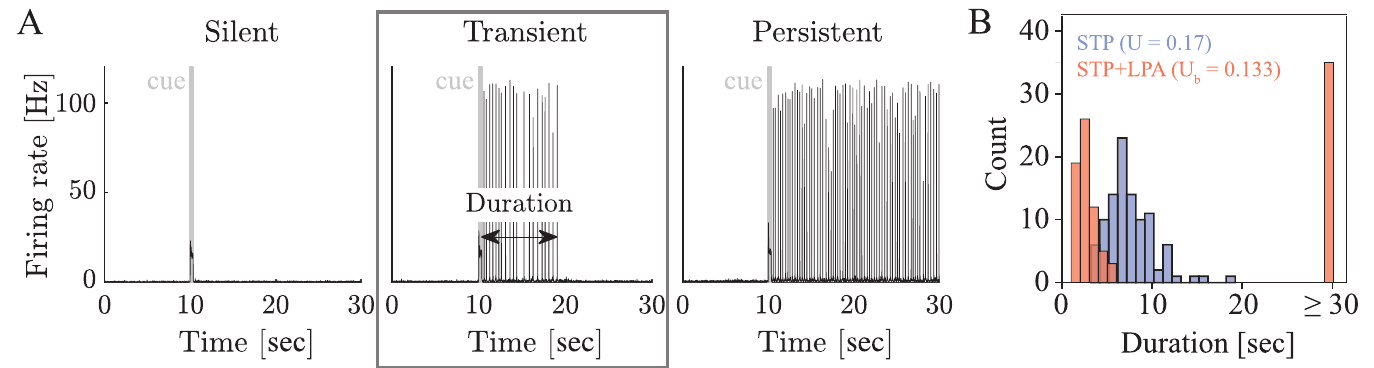
Fig 2. Astrocytic signaling leads to differences in synaptic WM termination. A Panels show the firing rate of the excitatory selective population of a representative STP +LPA spiking network during the WM protocol for three different levels of external baseline input current (remaining network parameters as in Table B in S1 Text). The network responds to the presentation of the WM cue (grey bar at 10s) with a silent (left, μ = 23.4 mV) WM representation. Equivalent WM regimes are observed in STP+LPA rate networks and STP spiking and rate networks (see subsequent figures). B Distribution of durations of the WM representations in STP and STP+LPA spiking networks in the transient regime for a fixed set of parameters (see subsequent figures). Even though both networks produce transient WM representations, the duration of the WM representation follows a homogeneous distribution in the STP network, but a bimodal distribution in the STP+LPA network. The same observations can be made for STP and STP+LPA rate networks (shown in subsequent figures).